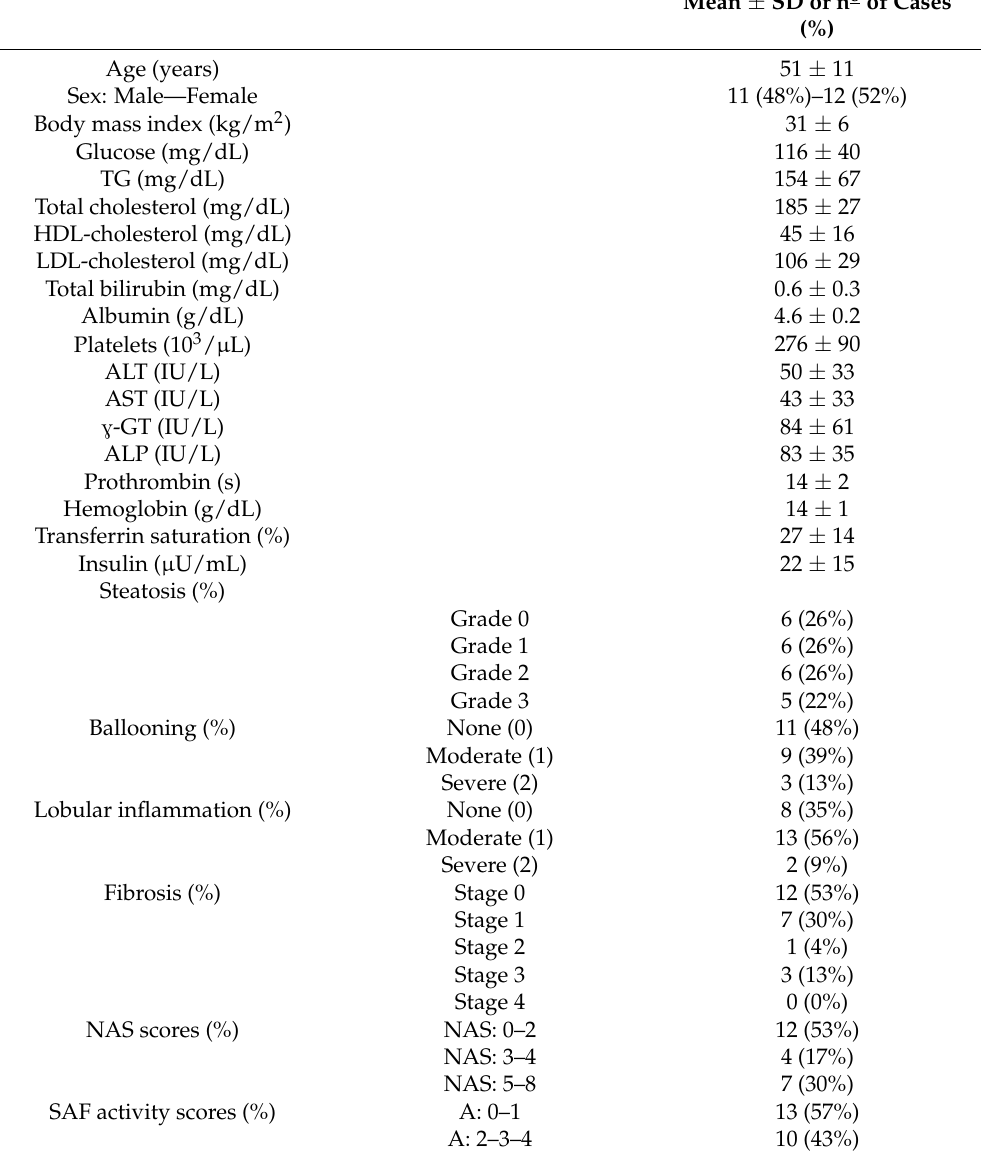
Table 4. Baseline characteristics of the NAFLD study cohort